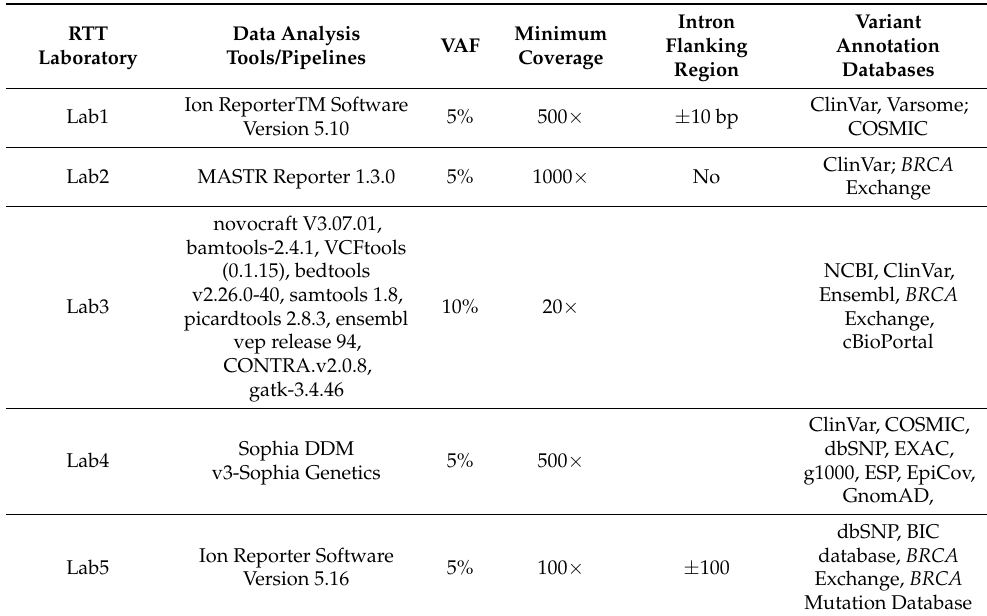
Table 5. RTT NGS bioinformatic